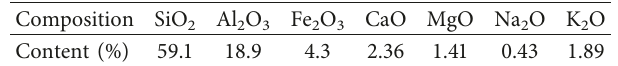
Table 3: The main chemical composition of coal gangue (%).